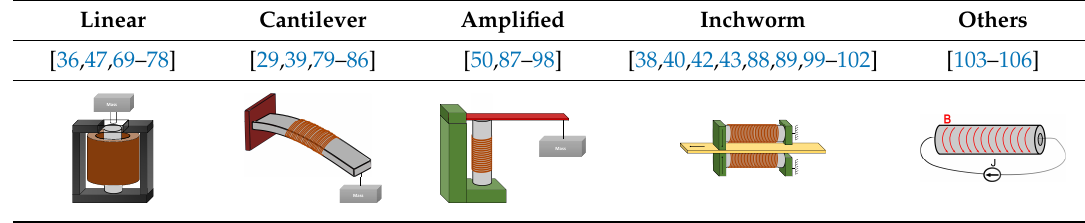
Table 2. Summary of the main geometrical configurations found for MA and related references.